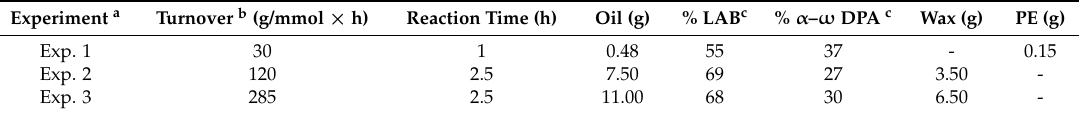
Table 1. Outlook on the performances of the catalytic complex EBTHIZrCl 2 activated by MMAO. Experiment